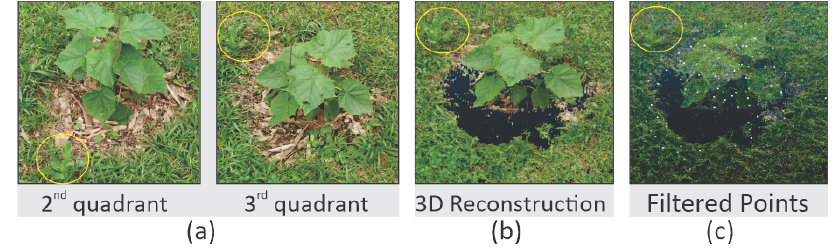
Figure 8. Example of Bush Reconstruction. ( a ) Images. ( b ) SFM. ( c ) After pre-processing.